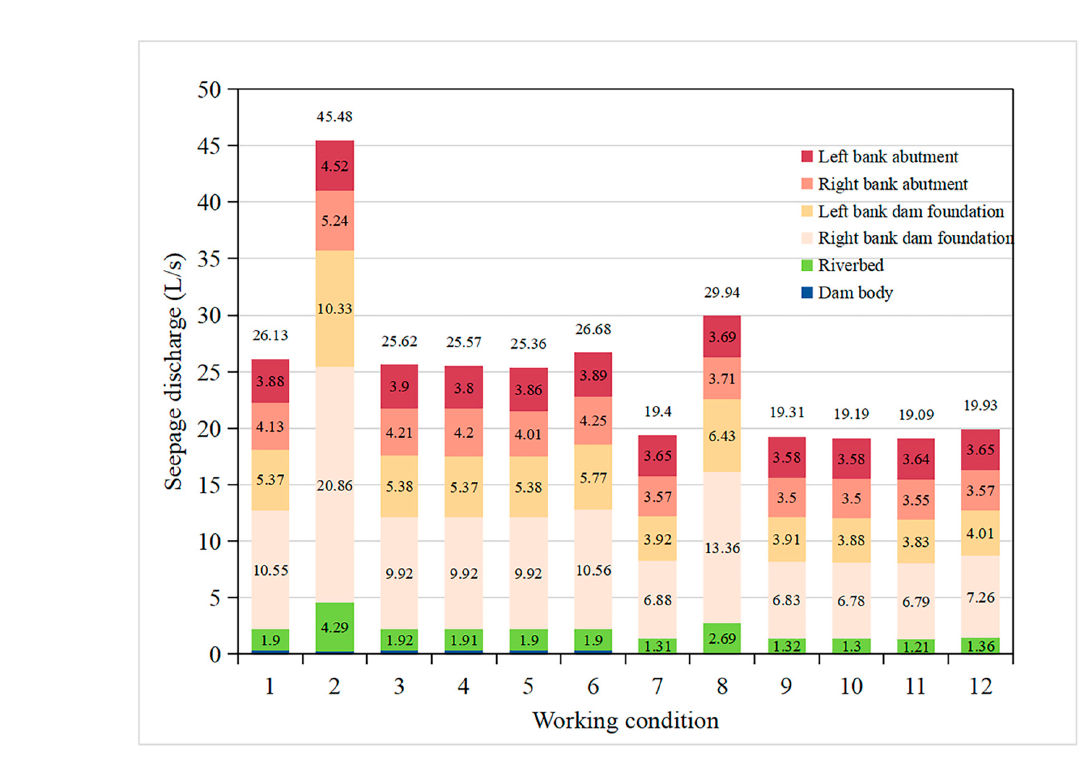
Figure 14. Seepage discharge of each partition of the Hami concrete-face rockfill dam’s axis section. The seepage discharges of the dam body are all less than 0.31 L/s, which is too small to be shown in the